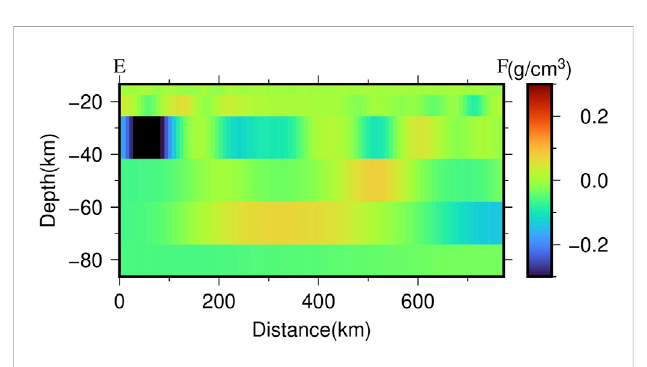
FIGURE 13 Pro fi